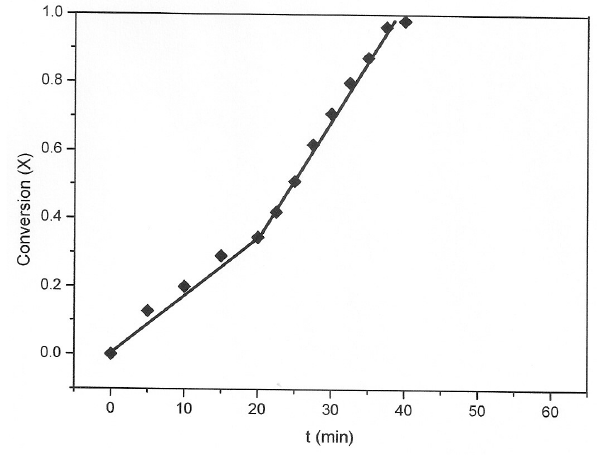
Figure 8. Effect of initial Cu 2+ concentration on thiosulfate transformation: Experiment performed at